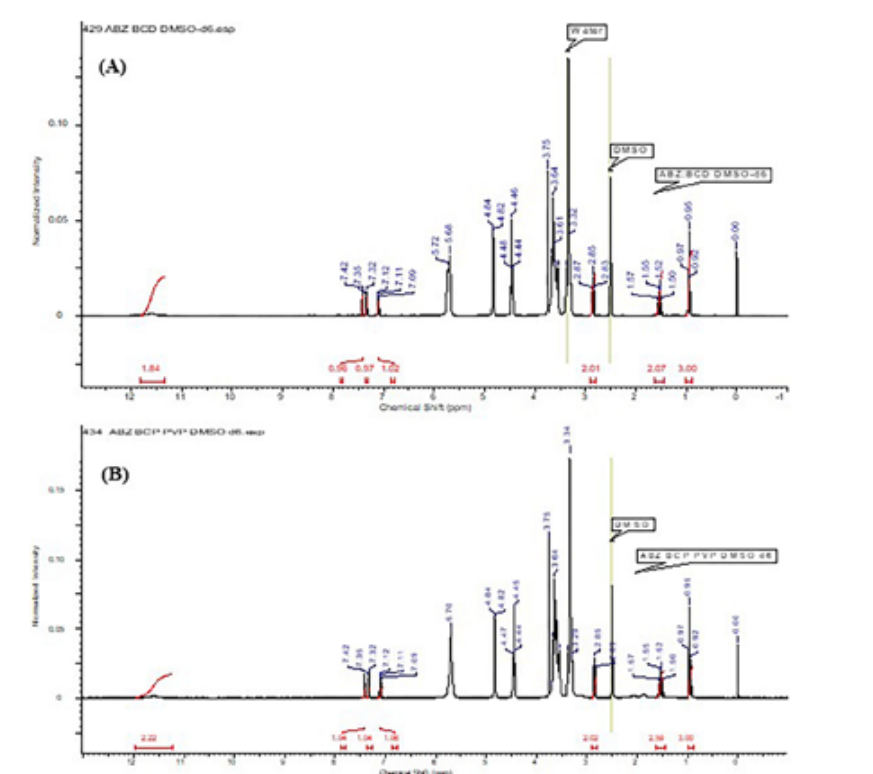
FIGURE 3 - 1 H-NMR spectra of ABZ in the presence of βCD (A) and the water-soluble polymer (PVP) (B) recorded in 300MHz DMSO-d6.